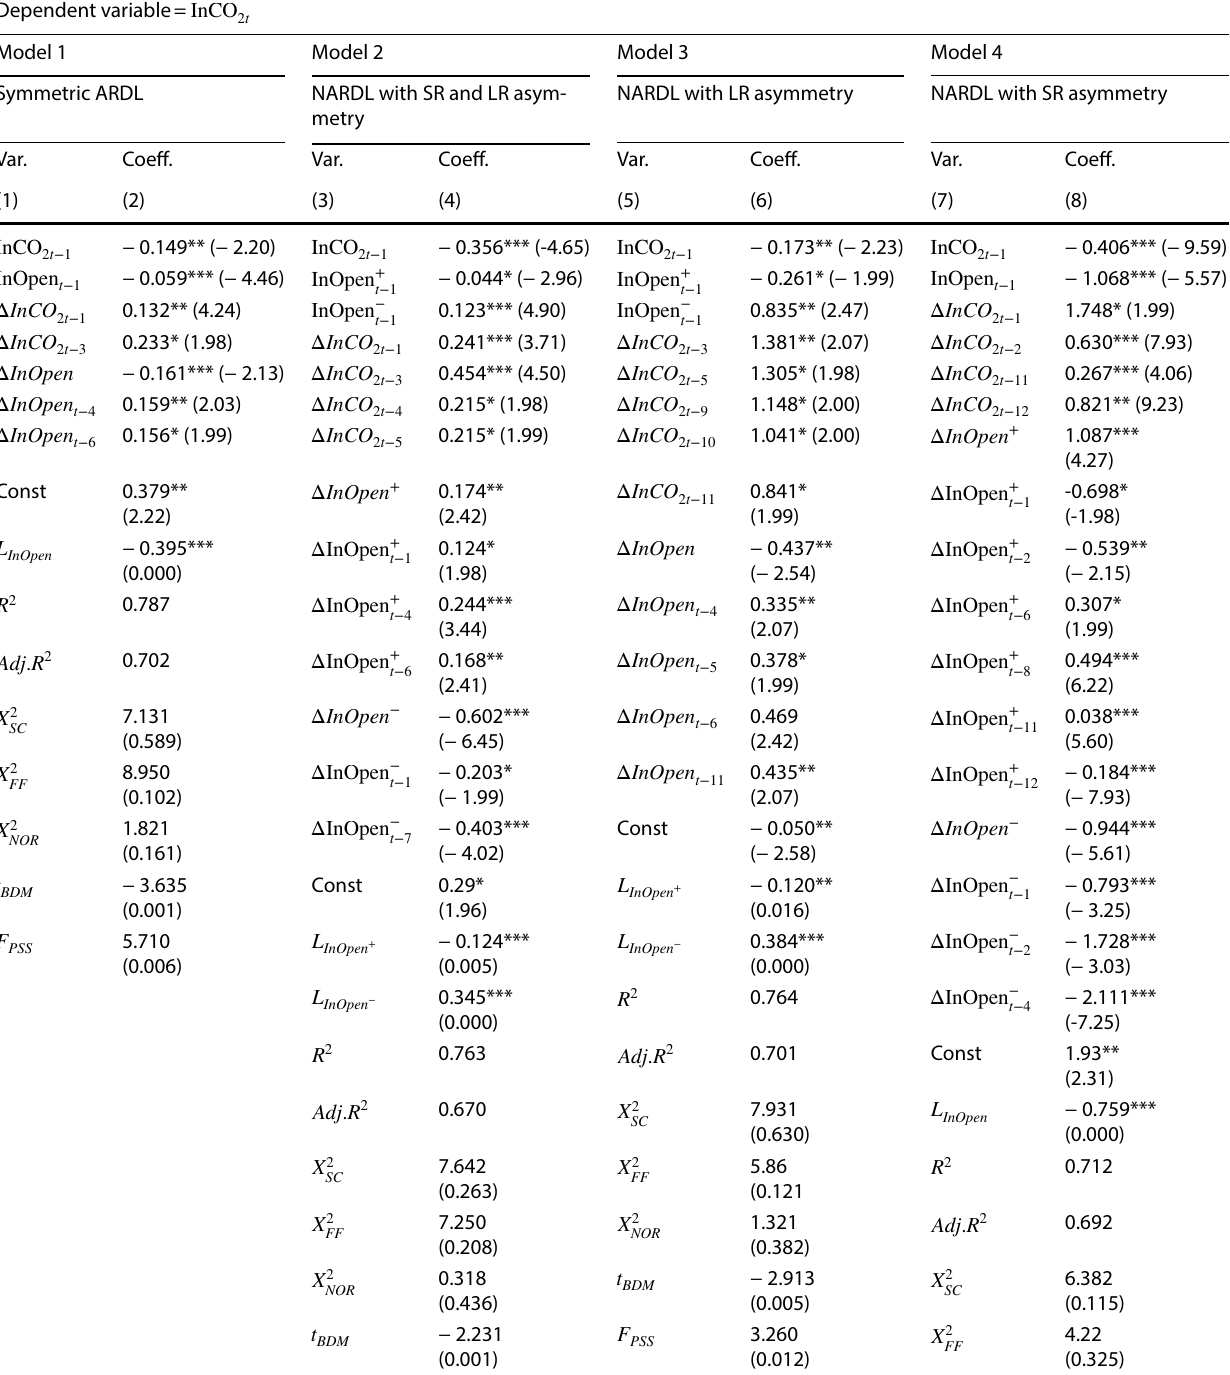
Table 3 Full-information estimates of both symmetric ARDL and nonlinear ARDL (NARDL) models in